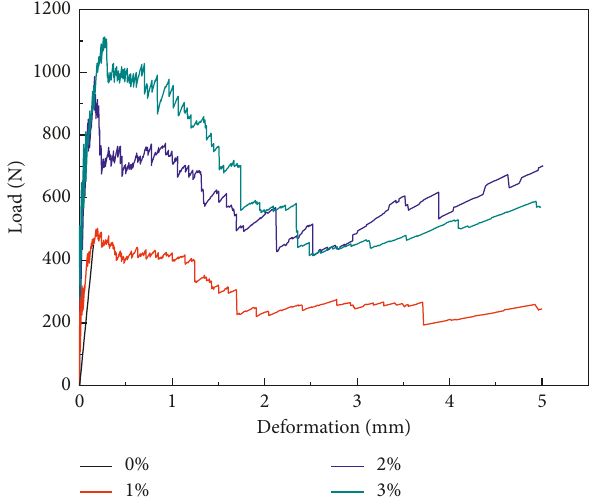
Figure 13: The simulated load-deformation curves for UHPFRC with different fiber contents.